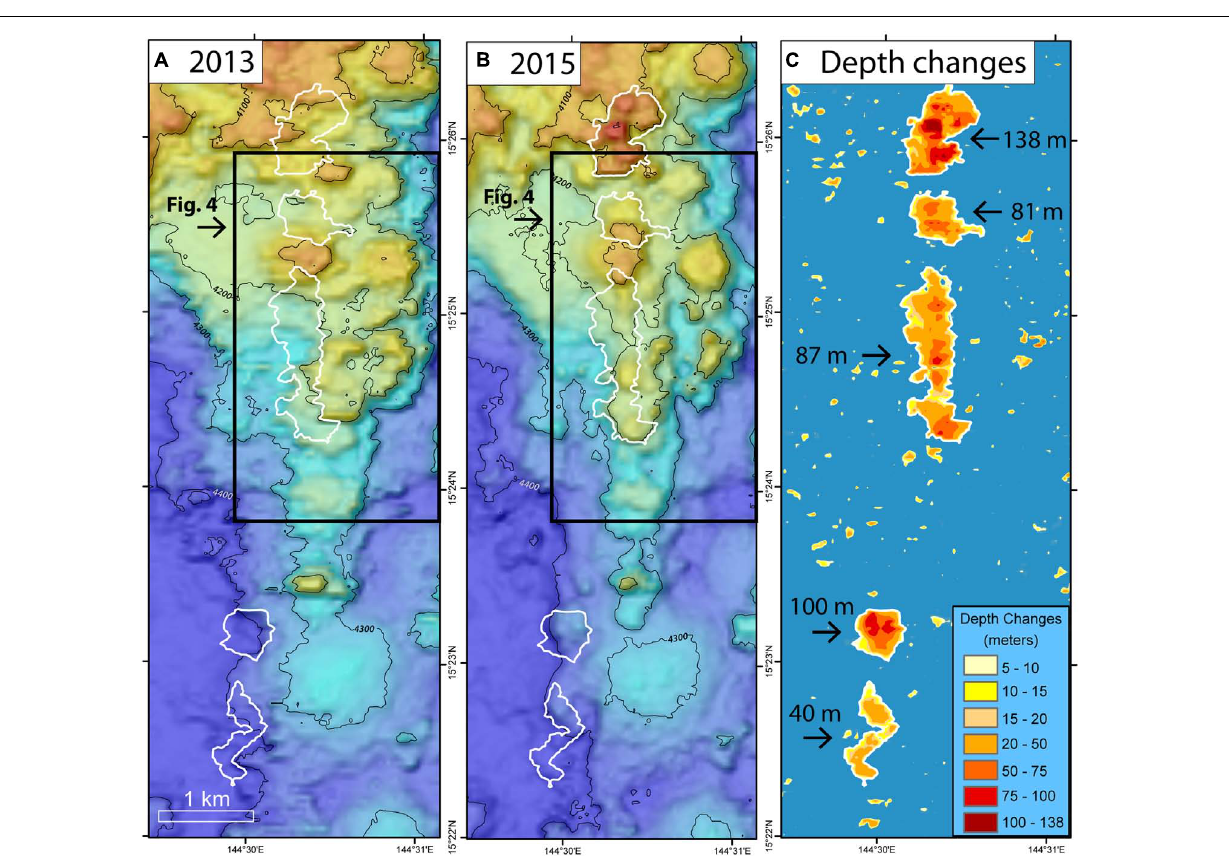
FIGURE 6 | Depth changes between ship-based multibeam bathymetric surveys (numbered 1–5 from north to south in Table 1 ). (A) Pre-eruption bathymetry collected in February 2013 by R/V Melville (MV1302a; EM122 sonar). (B) Post-eruption bathymetry collected in December 2015 by R/V Falkor (FK151121; EM302 sonar). (C) Depth differences between the two surveys showing 5 areas of significant depth change (outlined in white; color scale at lower right). Numbers indicate maximum depth change within each area. Black boxes show area of Figure 4